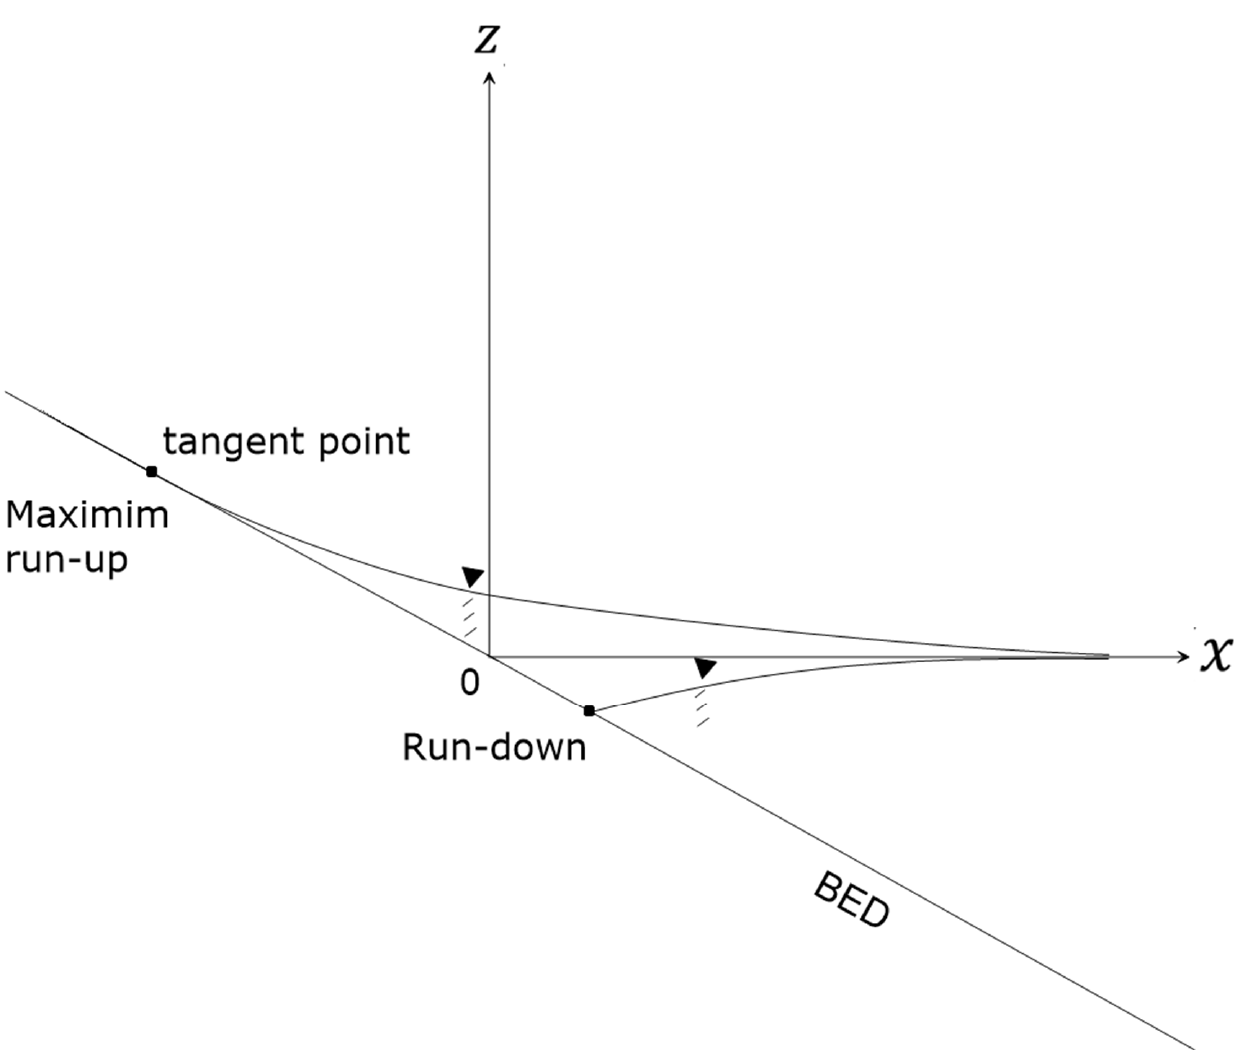
Figure 4. Maximum possible run-up of an edge wave.